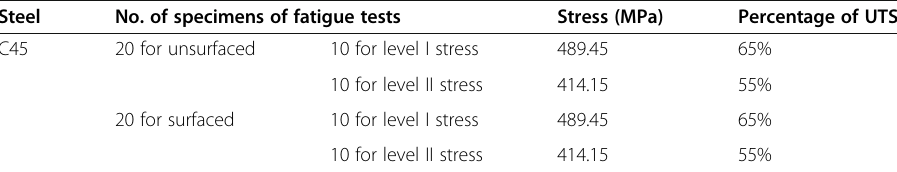
Table 3 Stress levels of fatigue test specimens Steel